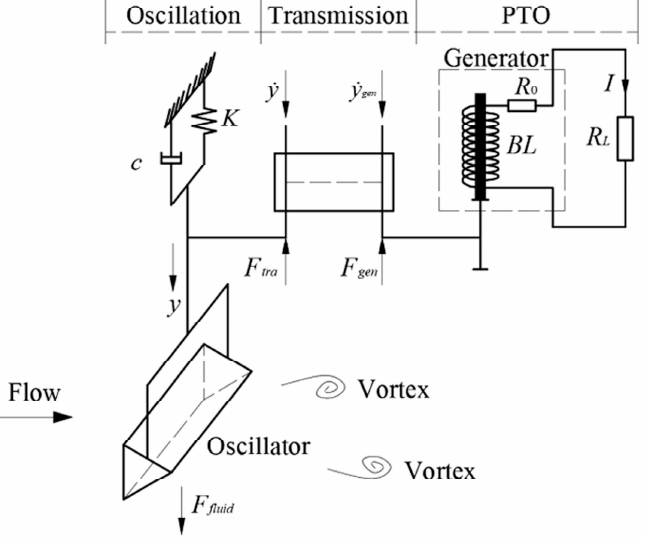
Figure 1. Schematic of flow-induced motion energy conversion (FIMEC) system